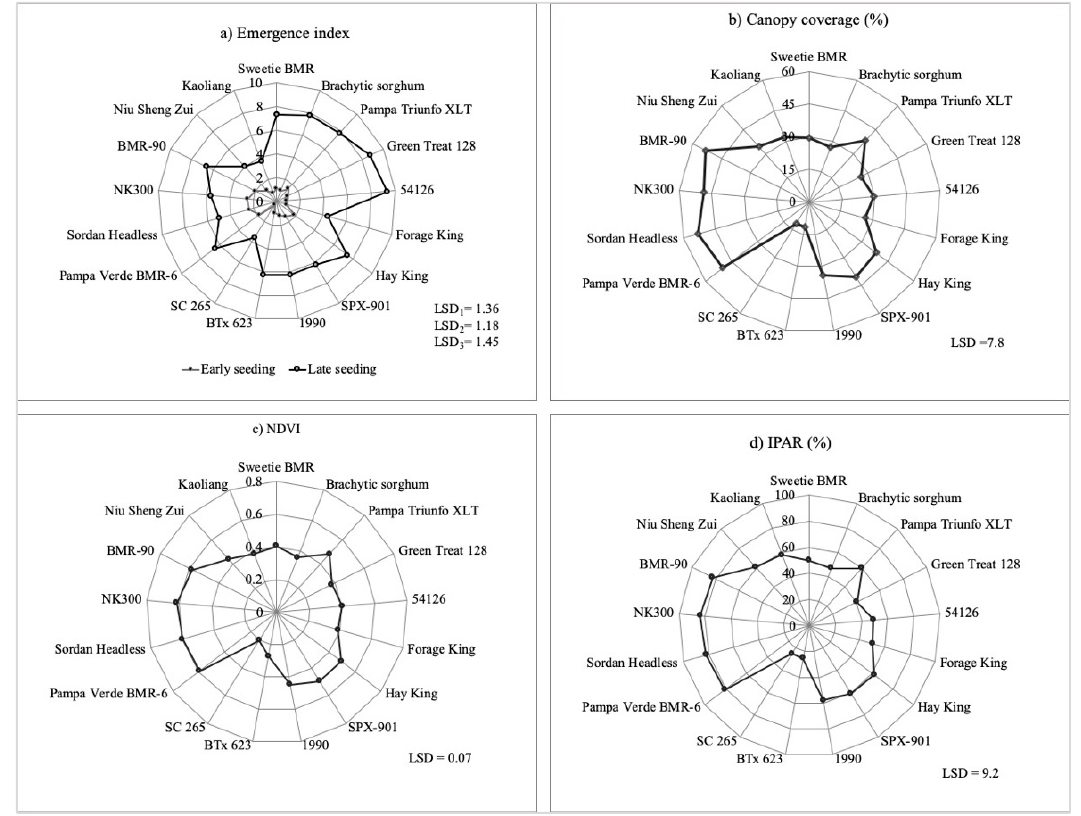
Figure 3. ( a ) Mean emergence index at early and late seeding, and ( b ) mean canopy coverage at 46 days after seeding (DAS), ( c ) mean normalized difference vegetation index (NDVI) evaluated at 49 DAS, ( d ) mean intercepted photosynthetically active radiation (IPAR) evaluated at 58 DAS in forage sorghum genotypes averaged across two seeding dates and four environments in Fargo and Hickson, ND, USA, in 2017 and 2018. Least significant differences (LSD 1) to compare among genotypes within the same seeding date, LSD 2 to compare same genotype between different seeding date, LSD 3 to compare among genotypes on different seeding dates, LSD in Figure 3b, 3c, and 3d are to compare among genotypes-mean averaged across seeding date within the same figure.